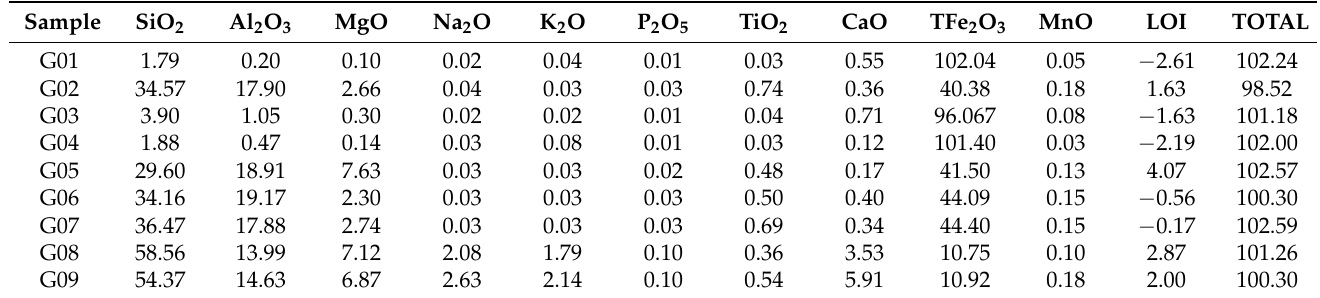
Table 1. Contents of major elements and related parameters of Gongchangling high-grade magnetite ore, altered wall rock, and amphibolite.